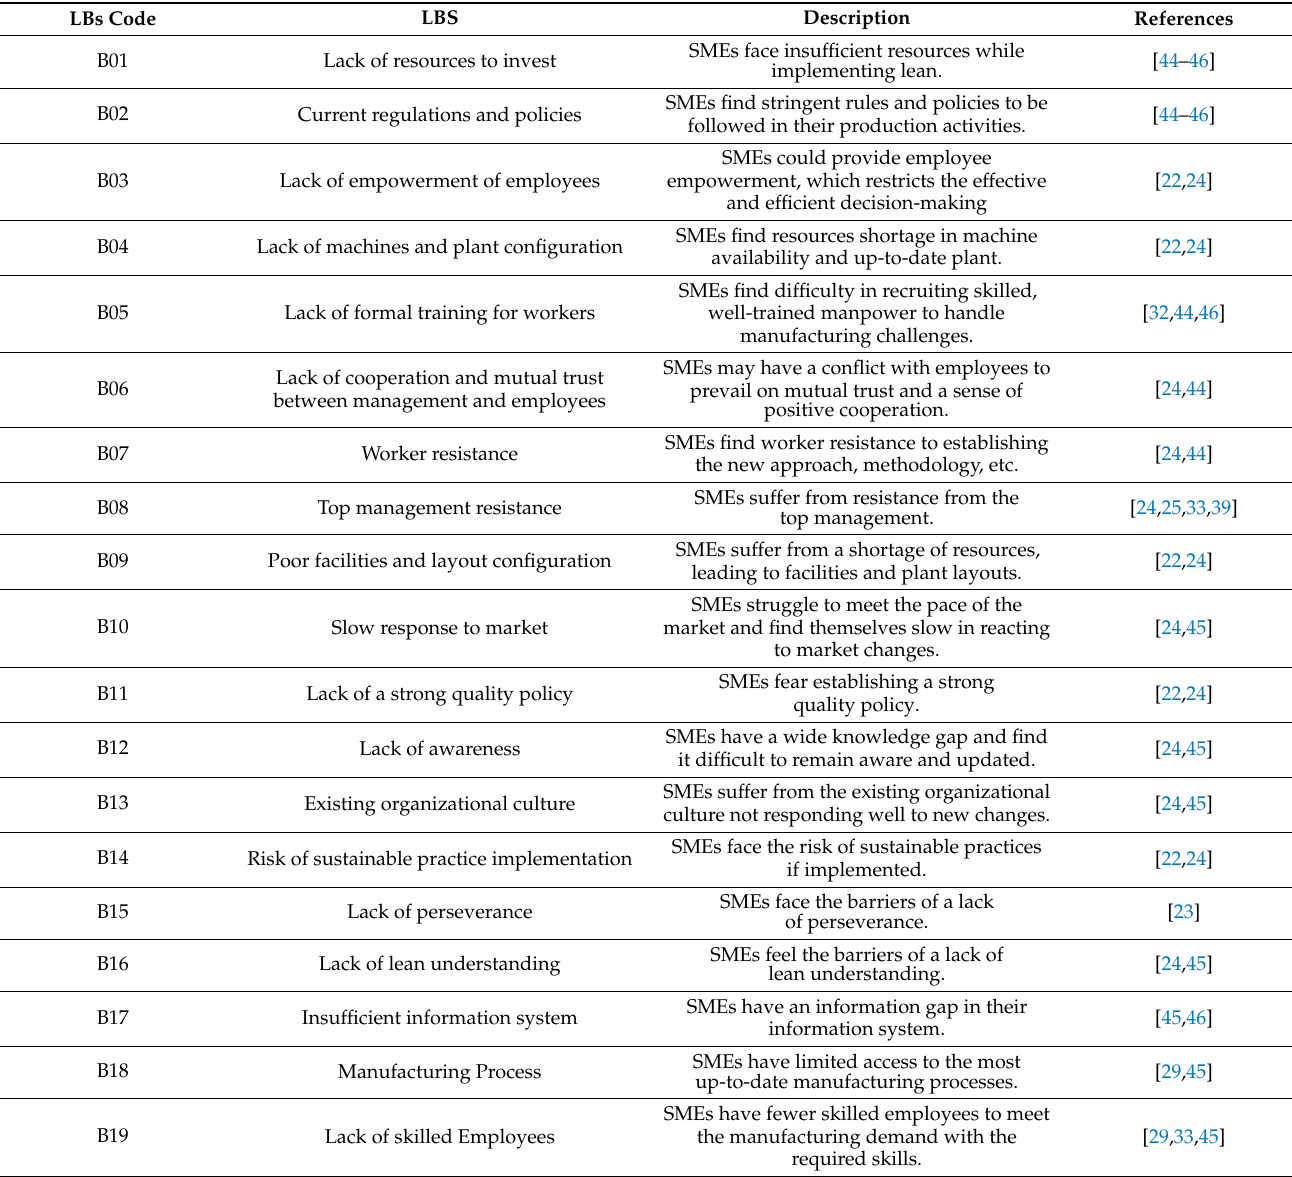
Table 1. Brief description and LB